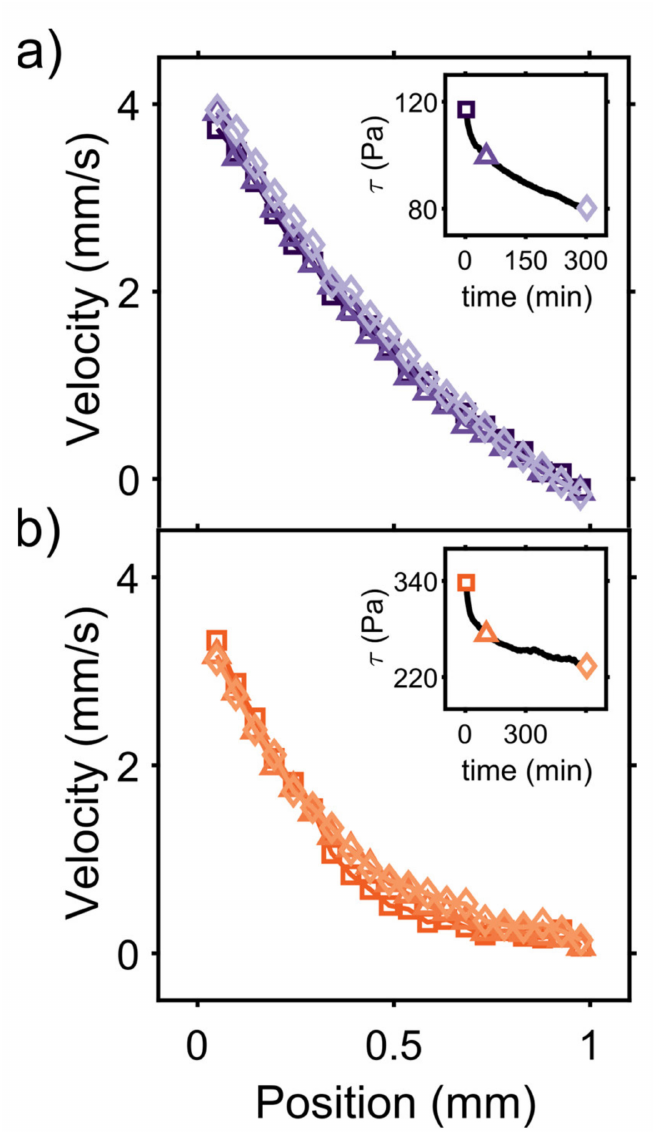
Figure A1. 1 H rheo-MRI velocity profiles of ( a ) EY and ( b ) MEY emulsions at different times during shearing experiments at 5 s − 1 : 2 min (squares), 50 min (triangles) and 300 min (diamonds). Insets show the associated stress values at each